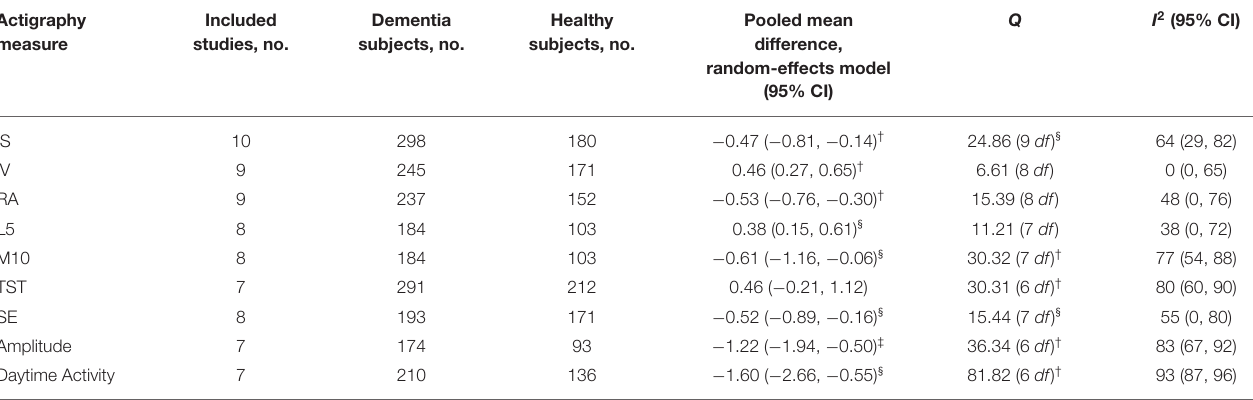
TABLE 7 | Combined effect estimates and heterogeneity for actigraphy outcomes between dementia and control samples. Actigraphy